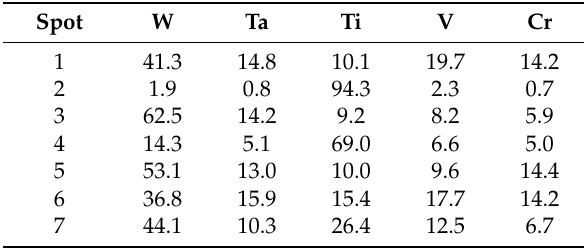
Figure 5. SEM micrographs of fractured surfaces from compression test at ( a , b ) 1000 °C, ( c , d ) 1200 °C, and ( e , f ) 1400 °C. Table 3. EDS analysis on fracture surface in Figure 5 in at. %.